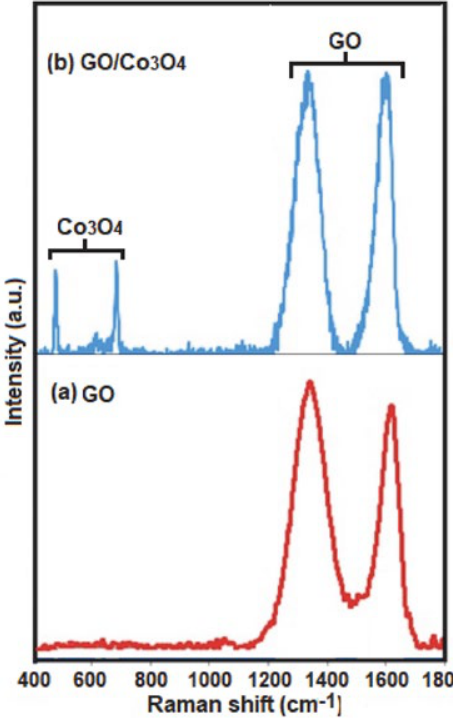
Figure 3. Raman spectra of (a) GO and (b) GO/Co